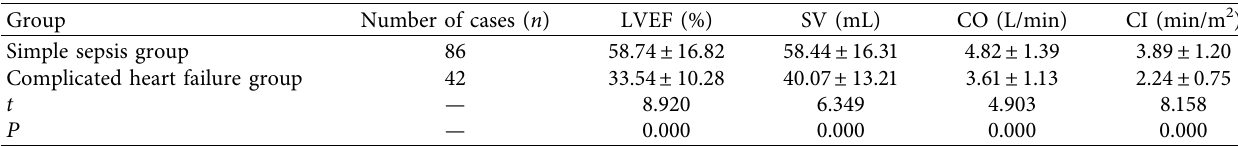
Table 2: Comparison of cardiac function parameters between the simple sepsis group and the complicated heart failure group. Group